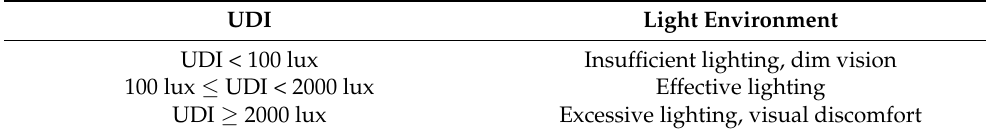
Table 2. The relationship between daylighting effect and illuminance interval divided by UDI index. UDI Light Environment UDI < 100